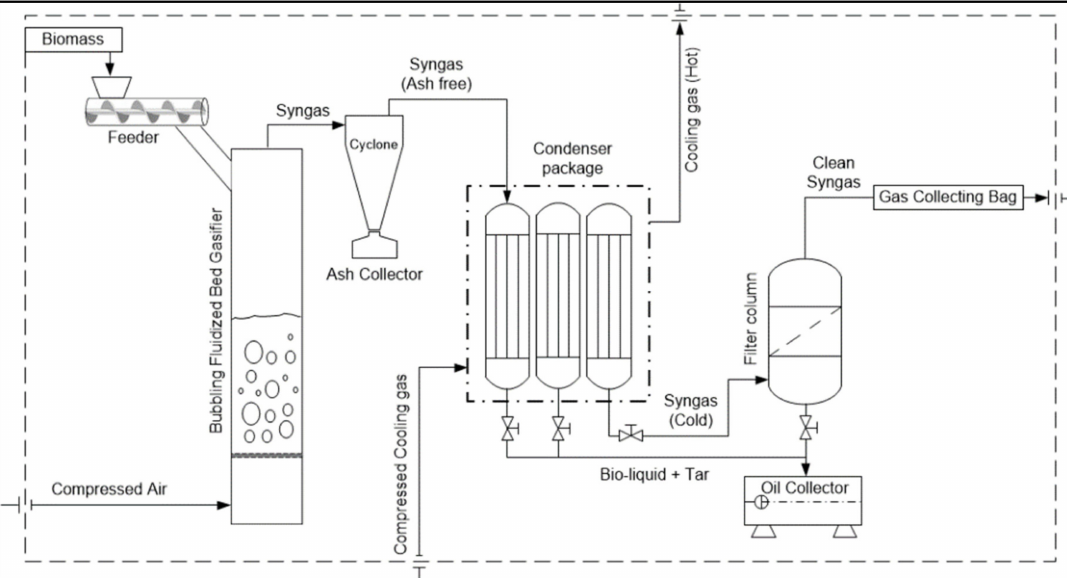
Figure 1. Process flow diagram of the gasification process for experimental